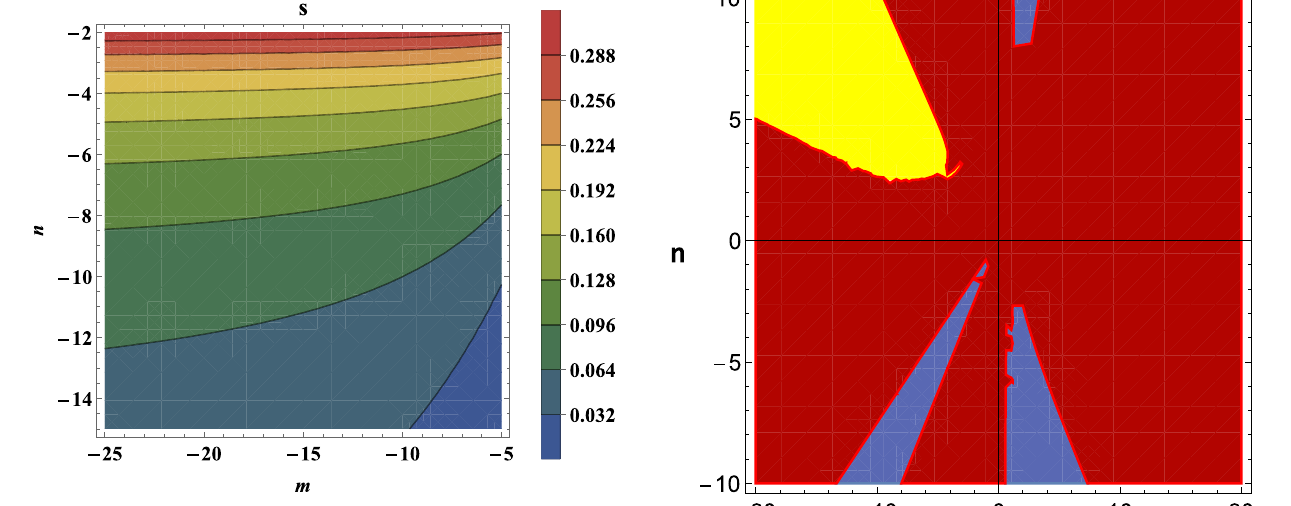
Fig. 4 The value of the s variable for the B critical point. For this figure we have displayed only the [ 0 , 1 ] interval 6 β H 3 ∂ t ( g (cid:4) ( P )) y 2 =